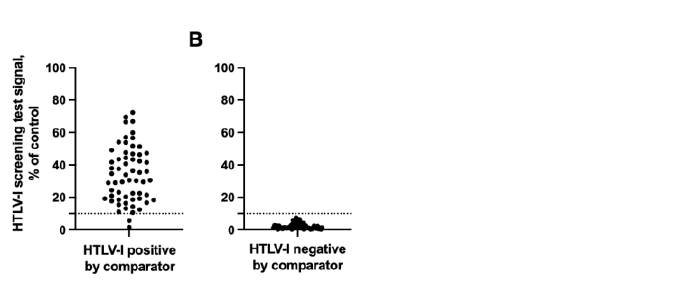
Figure 1. Screening rapid test performance on HTLV-I positive, HTLV-I and HTLV-II positive, or negative serum specimens collected in Salvador, Bahia, Brazil. Serum specimens collected from ( A ) HTLV-I or HTLV-I and HTLV-II infected individuals ( n = 60) or ( B ) HTLV negative individuals ( n = 58) were processed by the rapid screening test, then image captured.